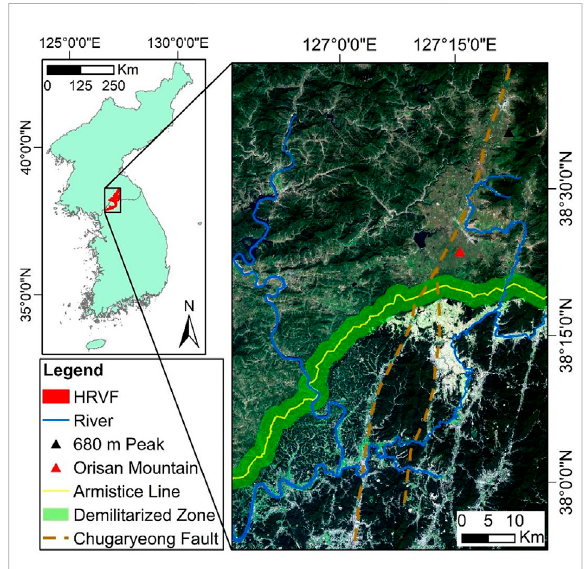
The Hantangang River Volcanic Field (HRVF) is depicted with Sentinel-2 satellite imagery with an RGB composite band in the middle Korean